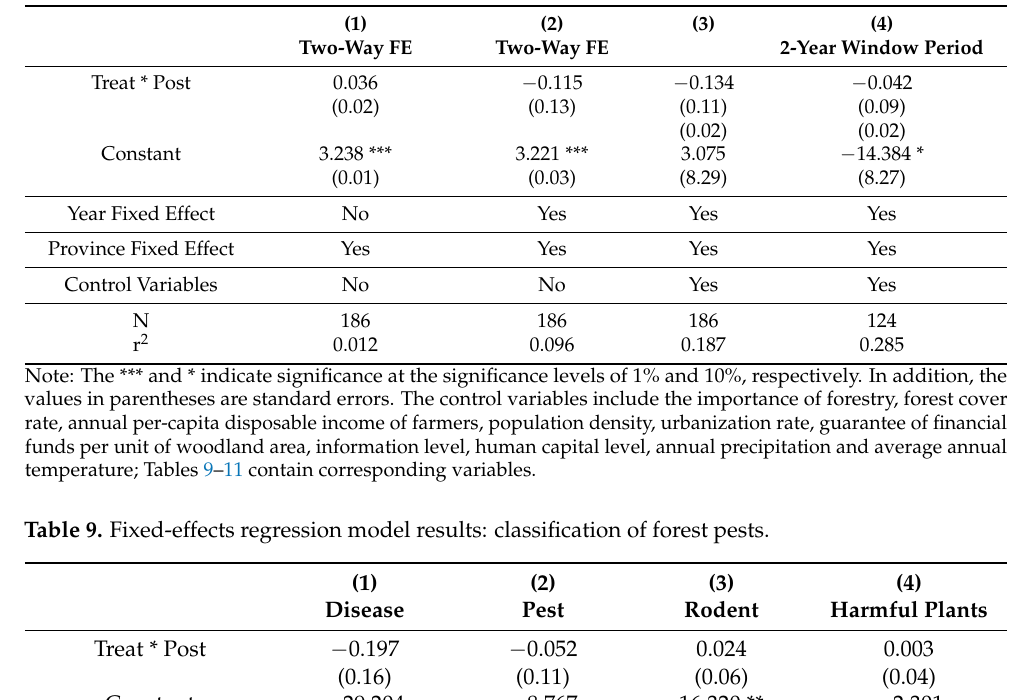
Table 8. Fixed-effects regression model results: logarithm of the area infested by forest pests.